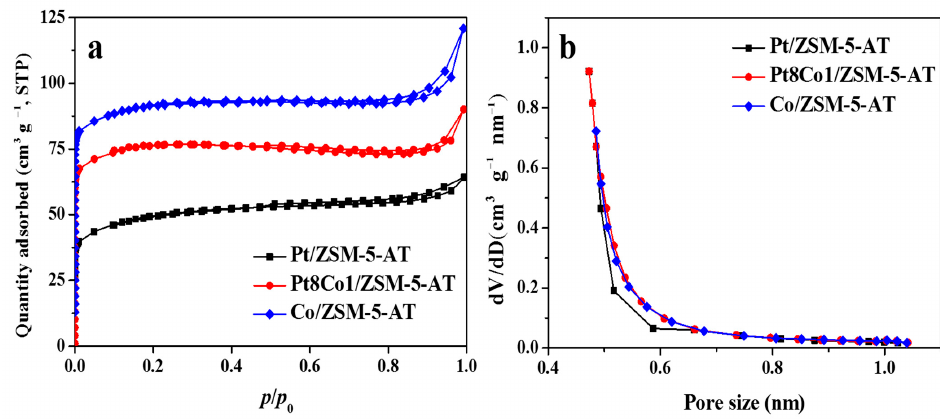
Figure 3. The N 2 adsorption–desorption curve ( a ) and pore diameter distribution ( b ) of the as-pre- pared Pt8Co1/ZSM-5-AT, Pt/ZSM-5-AT and Co/ZSM-5-AT catalysts.